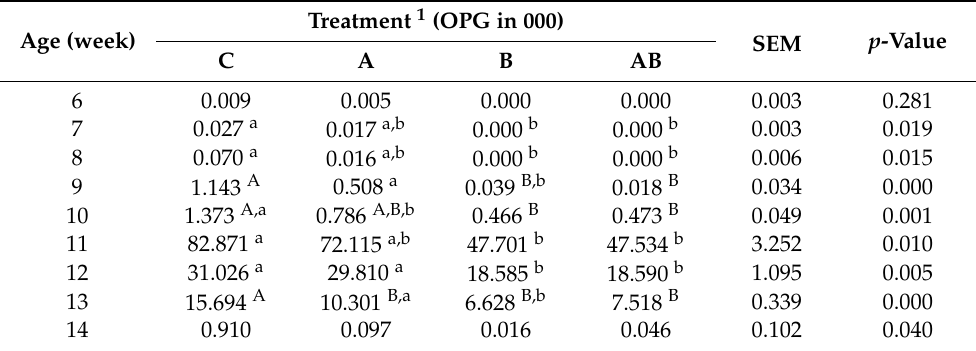
Table 3. E ff ect of the treatment on oocyt excretion (thousands) per gram of excreta (OPG) in naturally infected Kuroiler chickens.